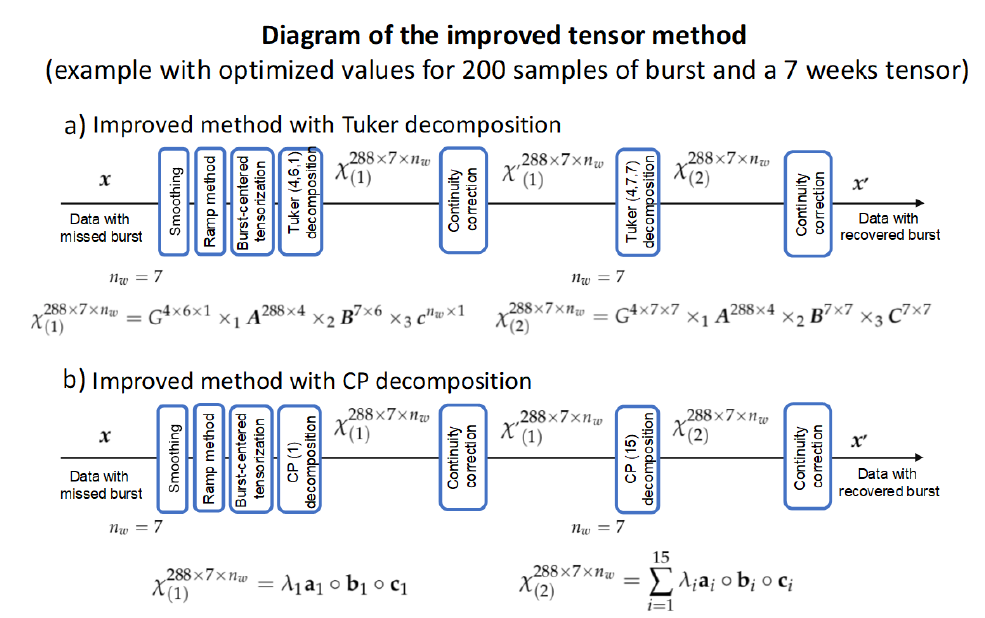
Figure 3. Graphic representation of the operations that compound the double tensor decomposition algorithm with the size of the decompositions optimised to recover bursts of 200 lost samples when employing a tensor size of 288 × 7 × 7. ( a ) when using the Tucker model. ( b ) when using the CP model.